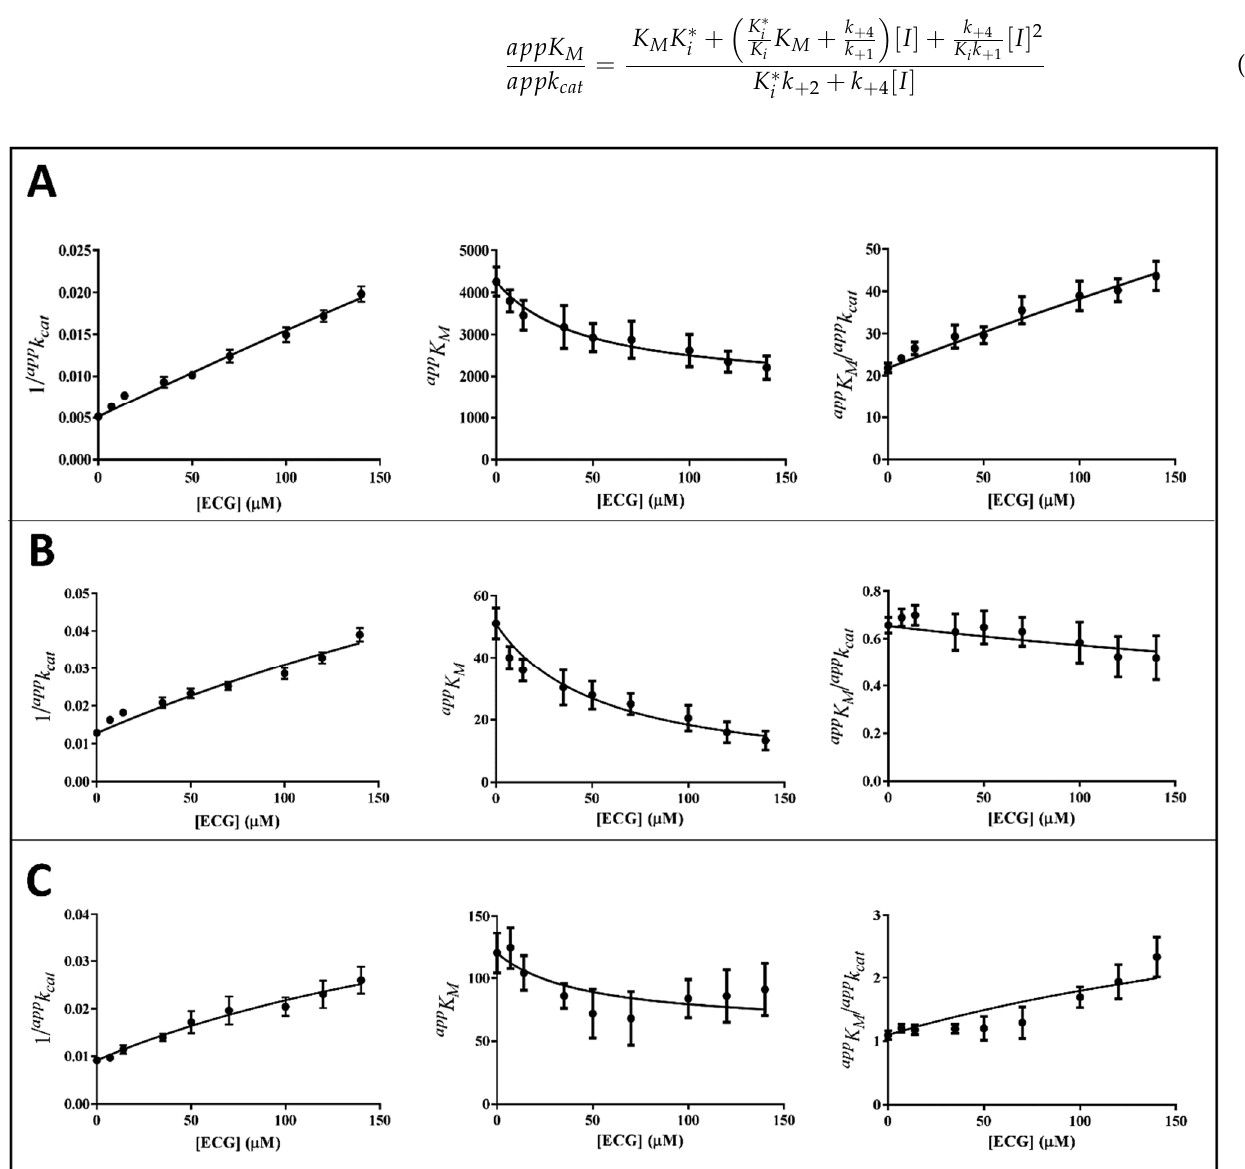
Figure 6. Kinetic analysis of ECG inhibition of the AKR1B1-dependent reduction of different sub- strates. Panel ( A – C ) refer to L-idose, HNE, and GSHNE, respectively. The secondary plots of apparent kinetic parameters at different [I] derived from the non-linear regression Michaelis-Menten analysis of primary kinetic data reported in Figure 3C. Bars (when not visible are within the symbols size) represent the standard error of the measurements. The parameters 1/ app k cat , app K M , and app K M / app k cat versus [I] were interpolated by non-linear regression using Graphpad Software 7.04. See the text for details.